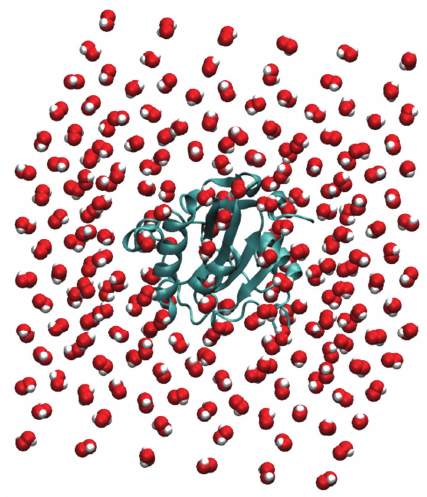
Figure 1: Simulation setup of glutathione peroxidase surrounded by hydrogen peroxide